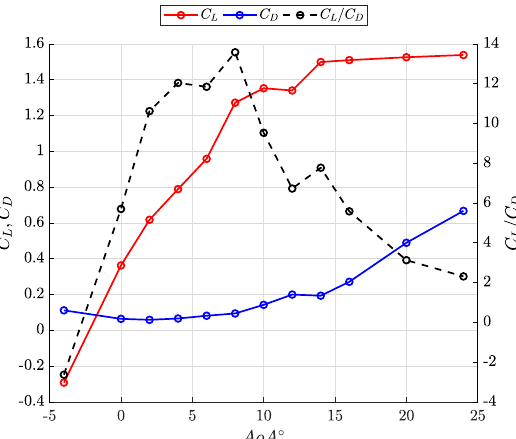
Figure 5. Lift coefficient C L , drag coefficient C D and lift to drag ratio C L / C D for Re = 10 4 against angle of attack AoA